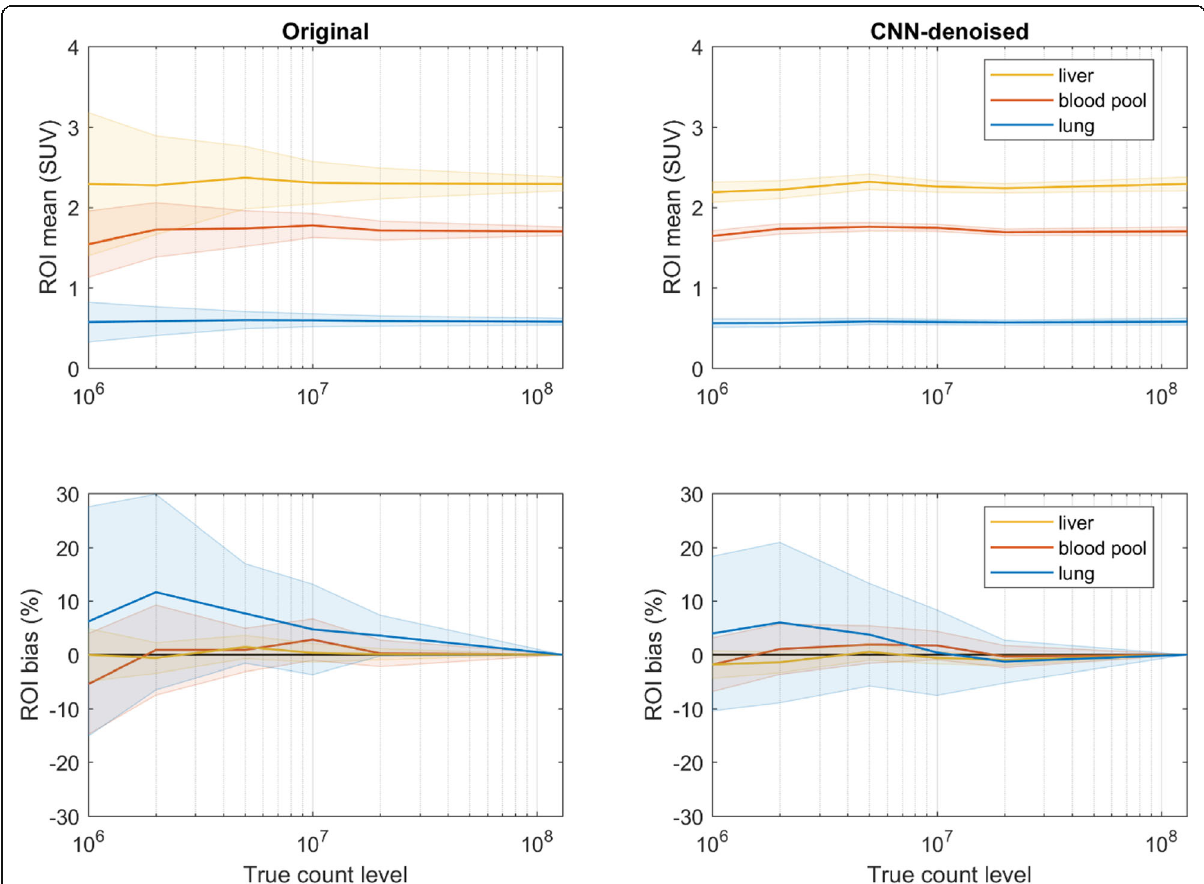
Fig. 6 Voxel values for VOIs drawn over various tissue regions shown for all count levels. In the top row, the VOI means are denoted by the solid lines with the standard deviation of the VOI values represented by the shaded regions. The means are similar between the original and CNN- denoised images, but the measurement variance was significantly reduced in the latter set. In the bottom row, the mean VOI bias (relative to the full-count set) is denoted by the solid lines with the respective standard deviation shown by the shaded regions. VOI measurement bias in the CNN-denoised images was, in general, similar to or slightly lower than that in the original images. The lower observed variances in the mean and bias measurements suggest higher reproducibility in VOI measurements for